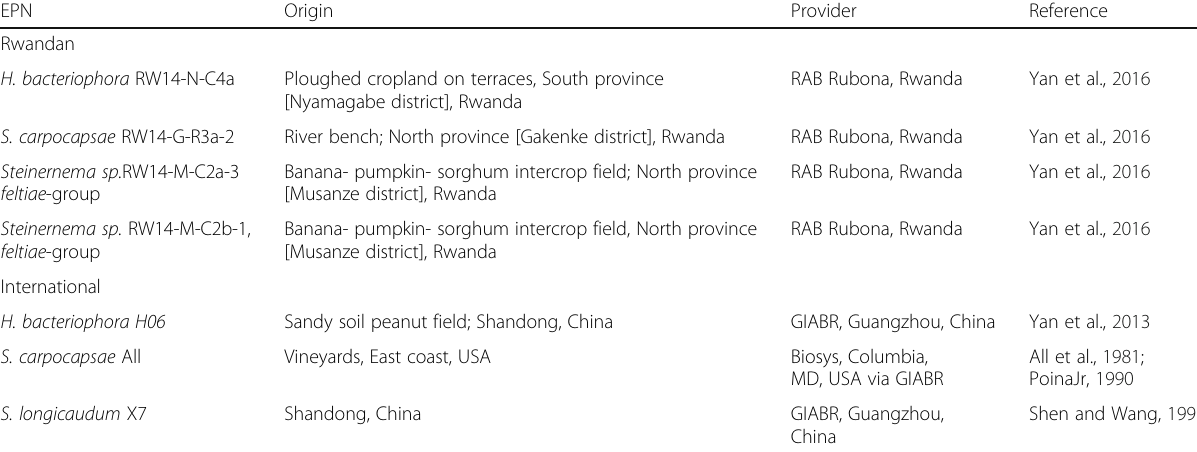
Table 1 Origin of Rwandan and comparative international entomopathogenic nematodes EPN Origin